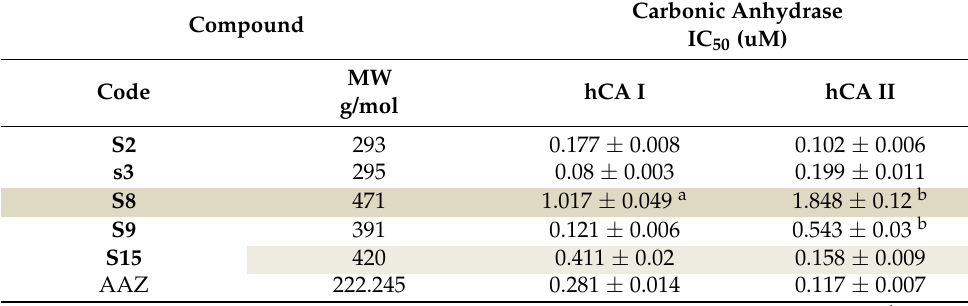
Table 2. Human CAI, II inhibitory effect of S2 , S3 , S8 , S9 and S15 compounds.